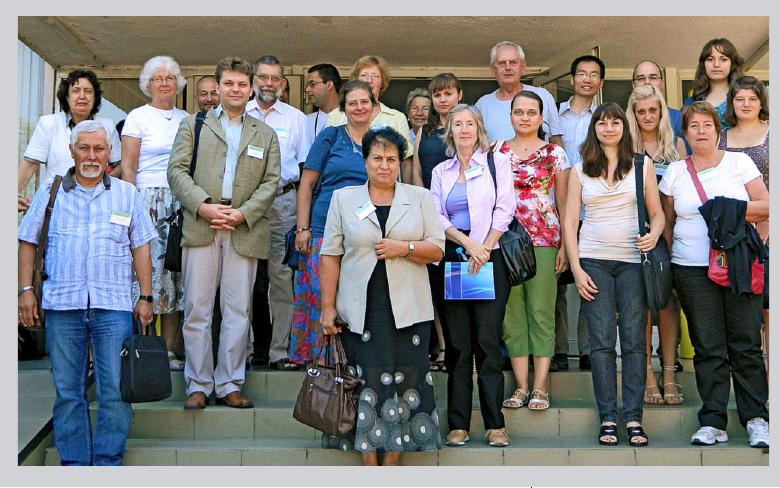
Figure 1: Participants in the 4 th